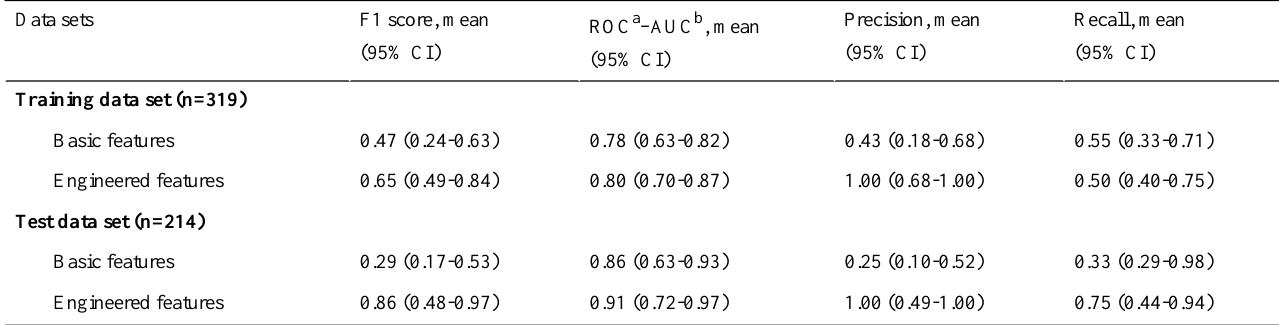
Table 4. Performance metrics of the training data set and the test data